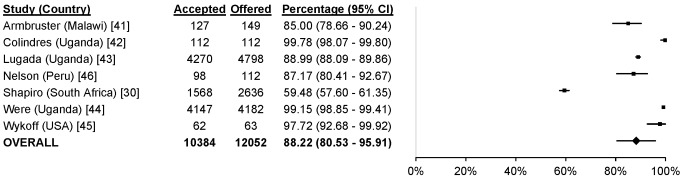
Uptake of index HTC.